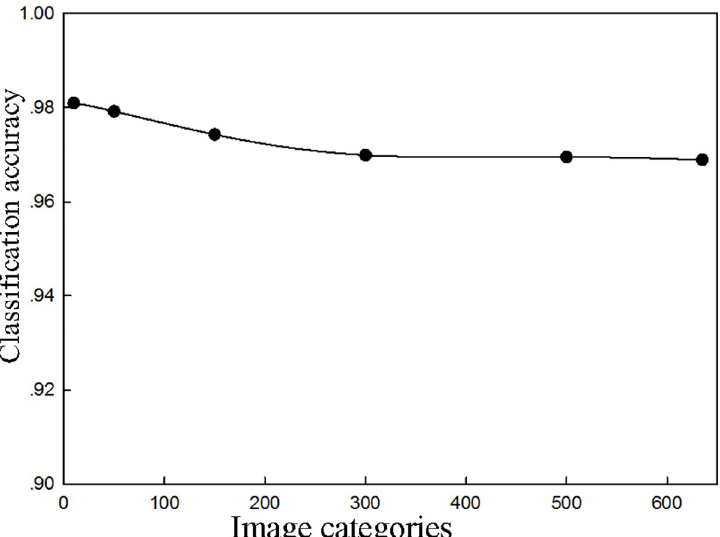
Fig 6. Comparison of the average classification accuracies of the proposed algorithm for different numbers of classification categories with varying numbers of images (Notes: 10 categories: 1,200 images; 50 categories: 6,000 images; 150 categories: 16,500 images; 300 categories: 31,800 images; 500 categories: 51,095 images; 635 categories: 80,000 images).